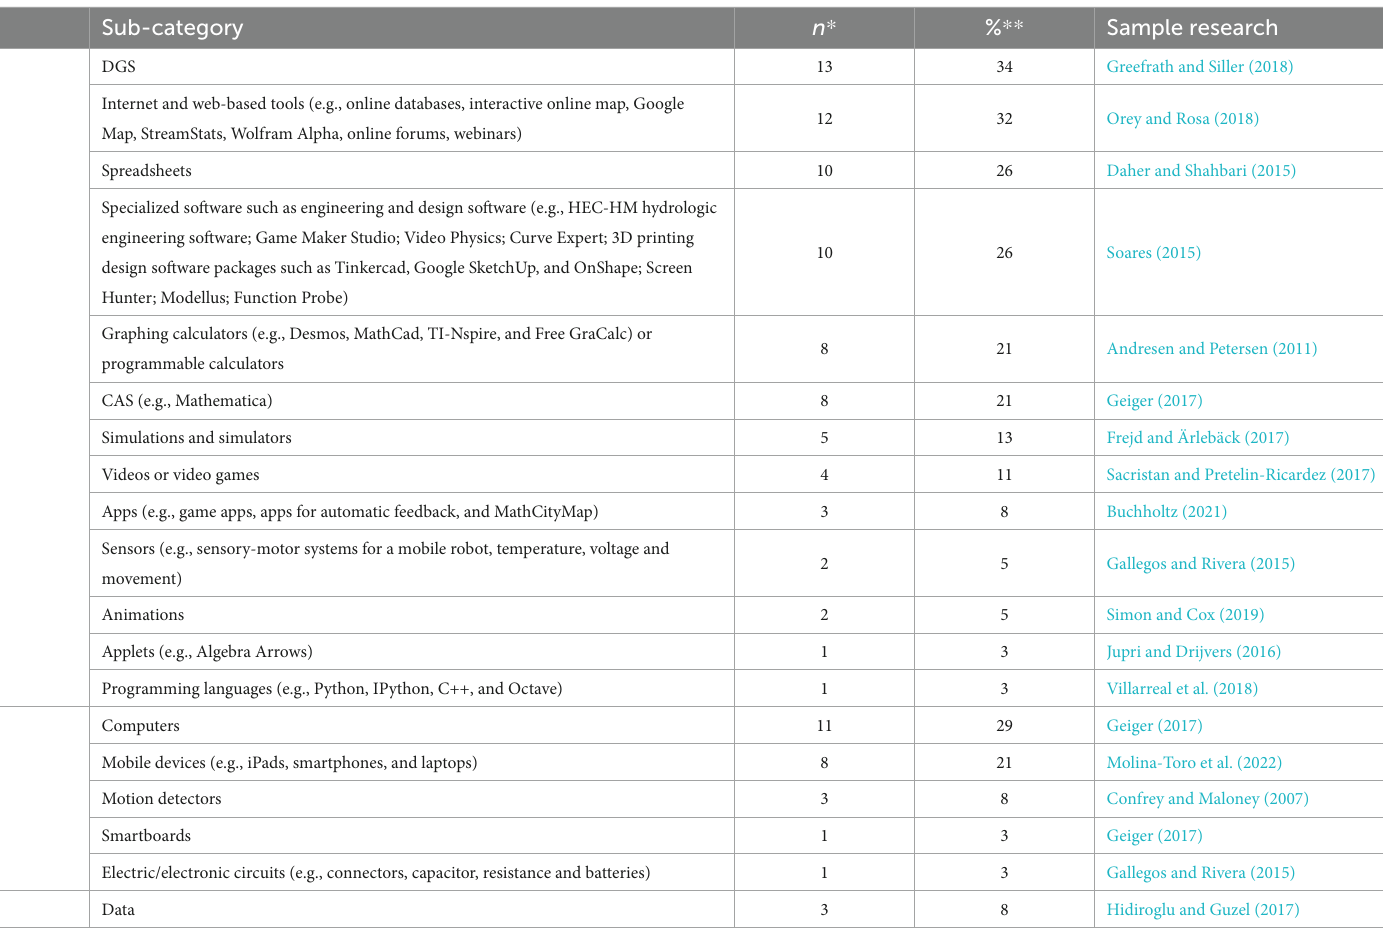
TABLE 4 Type of